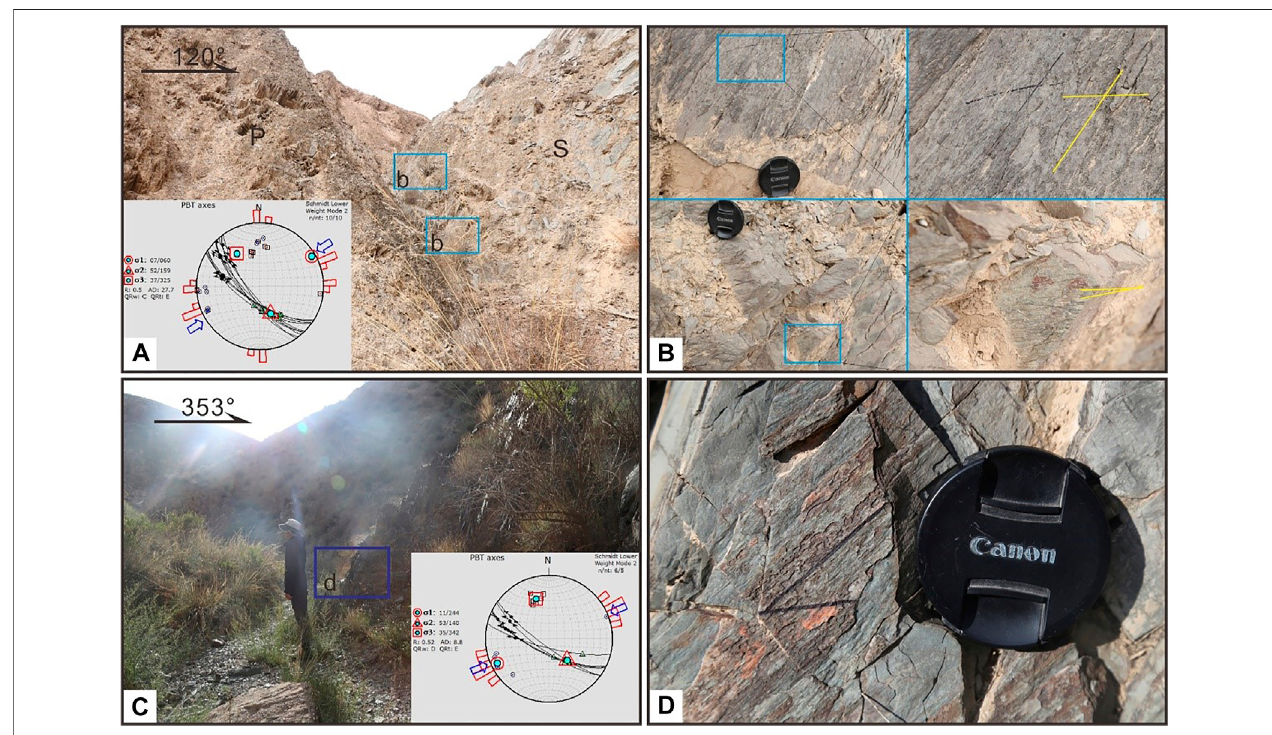
FIGURE6| FieldphotosoffaultplanesandscratchesintheLamazuiklippe (LMK).Yellowlinesmeanbedding.( Figure4 forregionallocationofthismap). (A) Fault planes located on the southern margin of the LMK. The scratches indicate that the area underwent NE – SW compression. (B) Two sets of scratches on the fault planes. The upper scratches indicate that the tectonic activity was dominated by thrust motion, while the other set indicates that tectonic deformation was dominated by strike- slip motion. (C) Fault plane on the northern margin of the LMK. The scratches indicate that this region experienced nearly NE – SW compression. (D) Scratches on the fault plane, indicating that the fault underwent a combination of thrust and strike-slip motion. K: Cretaceous strata. N: Neogene strata.